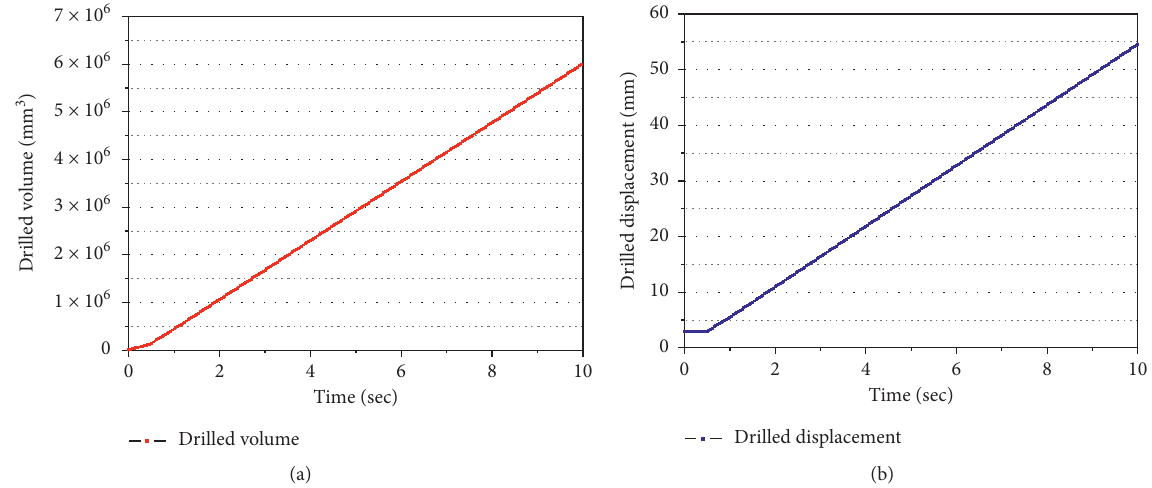
Figure 13: Predicted performance of drilling progression considering the effects of a button bit: (a) drilled volume and (b) drilled displacement.